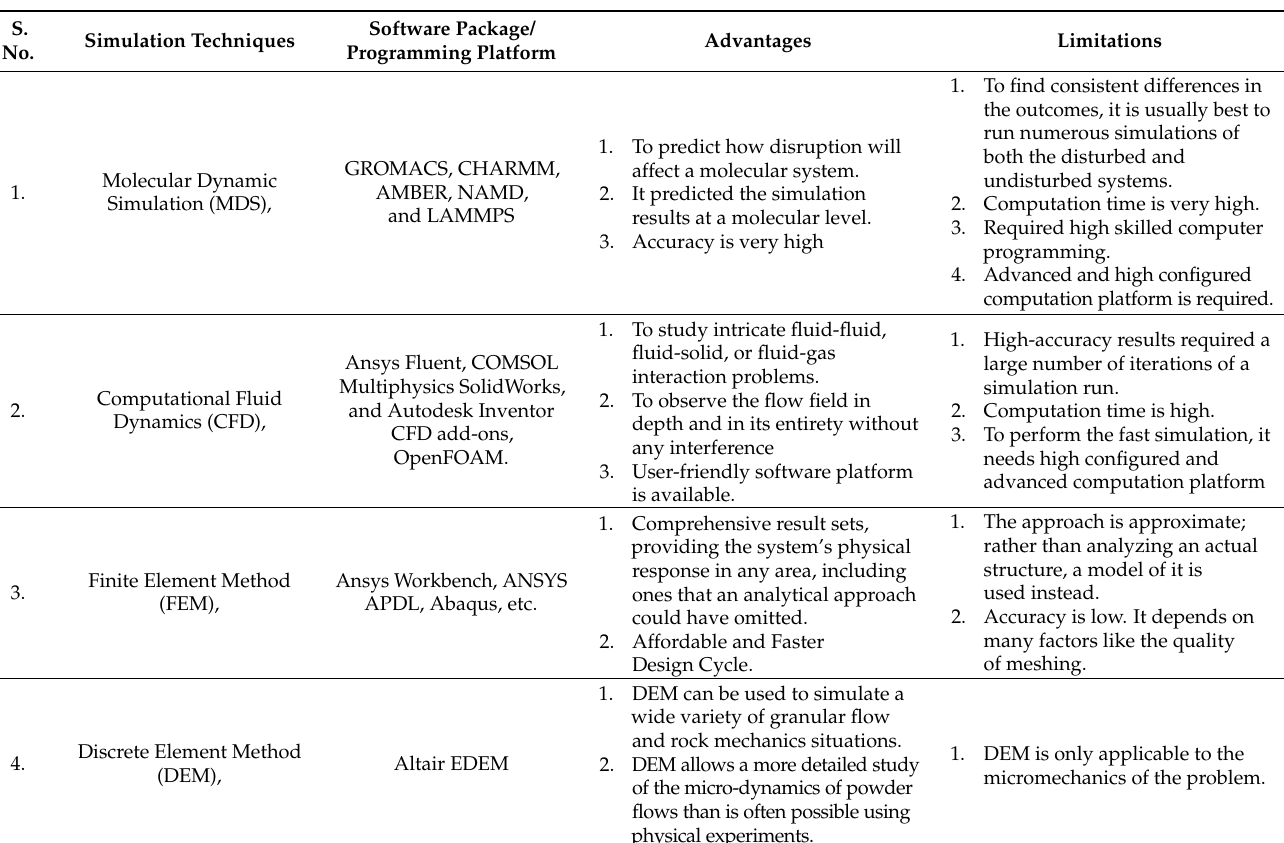
Table 5. A summary of the shortcomings of simulation techniques for Abrasive-based machining pro- cesses.